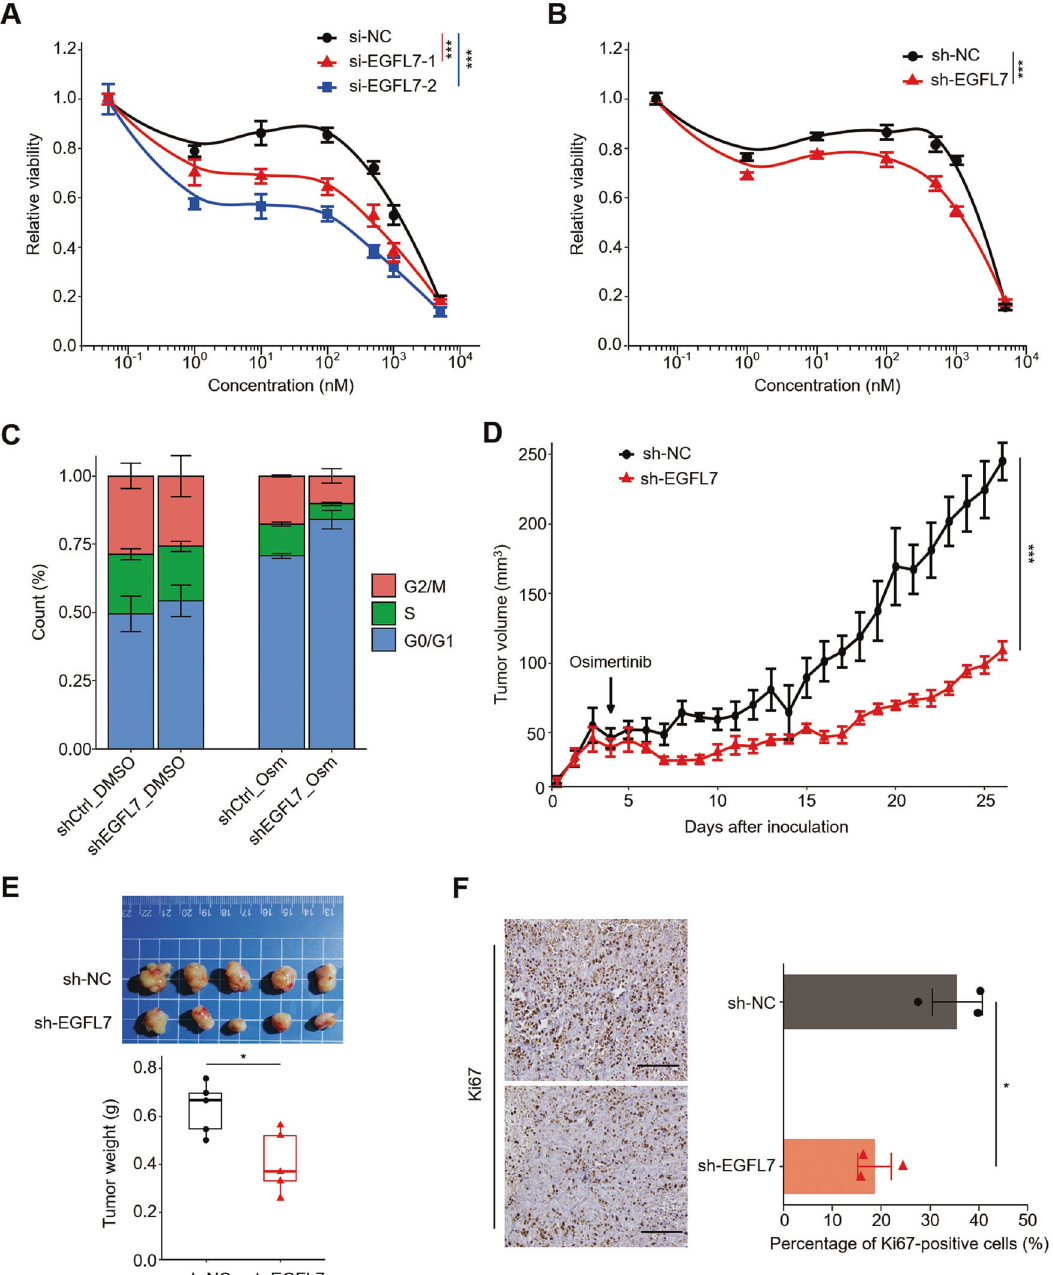
Fig. 2 EGFL7 promotes resistance to EGFR inhibitors in acquired resistance phase. Survival curve of osimertinib-resistant PC9 (PC9OR) cells with the indicated si-RNAs ( A ) or sh-RNAs ( B ) in different concentration of osimertinib treatment for 72 h. Data present as average of four identically wells of percentage of surviving cells to 6 wells of vehicle-treated control. C Cell cycle distribution of PC9OR cells with the indicated sh-RNAs treated with 2 µM osimertinib or vehicle. Data present as mean ± standard deviation (SD) of three biological replicates. D Growth curves of tumor xenografts derived from EGFL7-knockdown PC9OR cells or control cells treated with 3 mg/kg Osimertinib. E Images of the indicated xenograft tumors (upper panel) and statistical analysis of tumor weight (lower panel). F Left panel showing the representative images of Ki67 staining in the indicated xenograft tumors, and right panel showing statistical analysis of the percentage of Ki67 positive cells. Scale bar: 200 µm. The data in right panel ( F ) are average value of three biological replicates. The data in E are average value of fi ve biological replicates. The median line in E represents median values. The top and bottom of box in E are 25th and 75th percentiles. Data in A , B , D – F are shown as mean ± standard error of the mean (SEM). p values in A , B , D are calculated by two way ANNOVA. p values in E and F are calculated by unpaired two-tailed Student ’ s t t est (* p < 0.05; *** p <